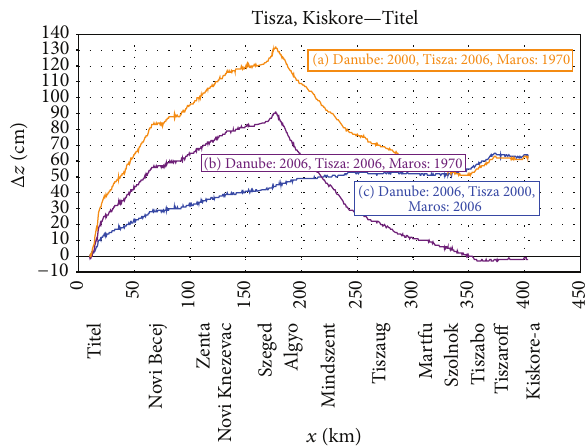
Figure 7: The calculated peak water levels for different flood superposition